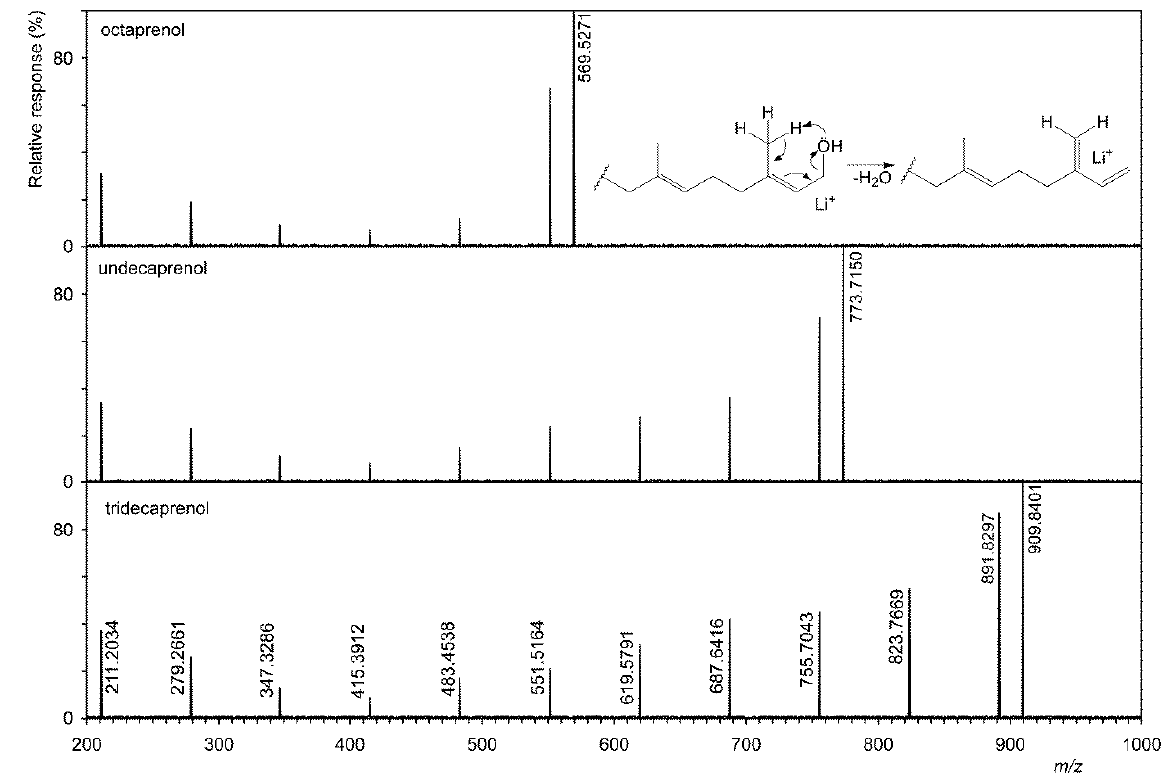
Figure 3. Tandem mass spectra of shortest (octaprenol, i.e., C40), most abundant (undecaprenol, i.e., C55), and longest (tridecaprenol, i.e., C65) polyprenol homologues.